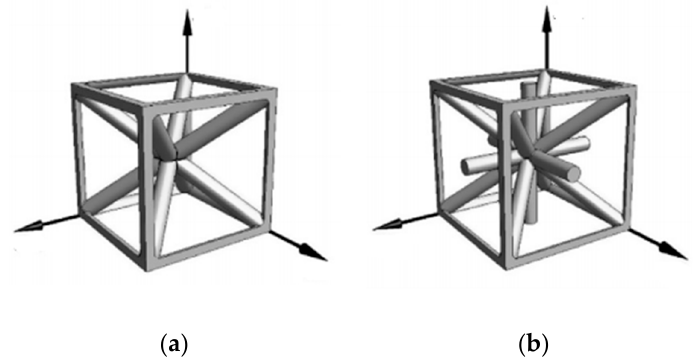
Figure A5. ( a ) Body centered cubic (BCC); ( b ) reinforced body centered cubic (RBCC) [147].